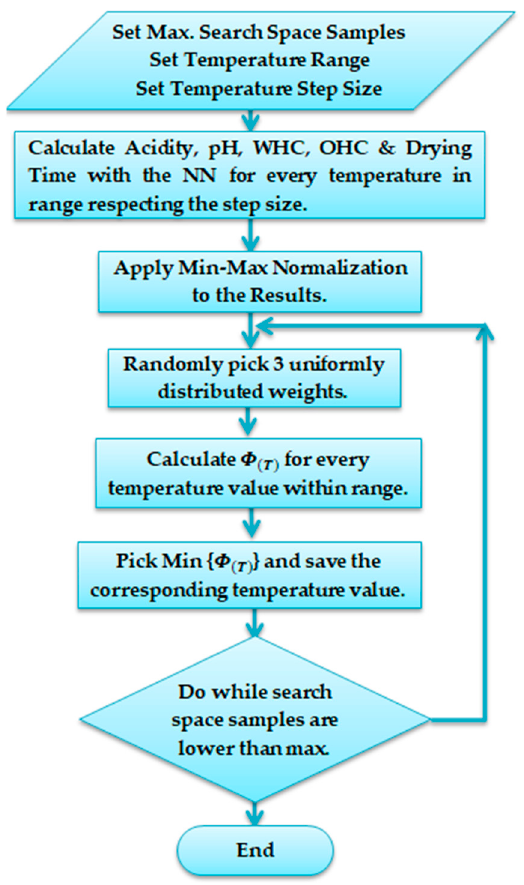
Figure 5. Flowchart describing the search algorithm used to determine the Pareto-optimal set. All code inside the while loop may be executed in different threads since every iteration is independent.